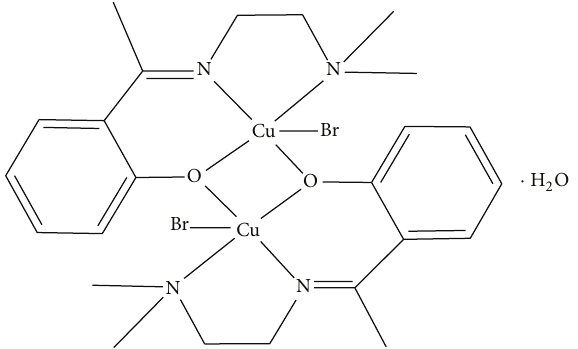
Figure 1: Chemical structure of Cu(BrHAP) 2